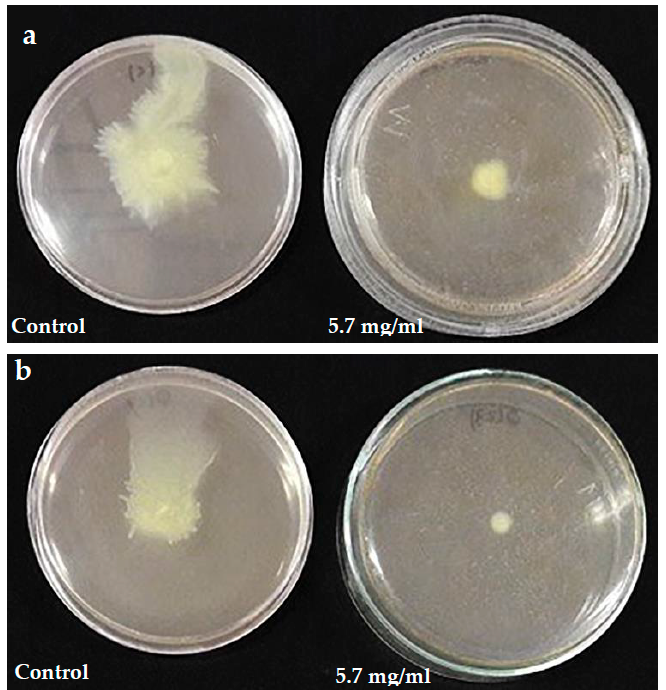
Figure 8. Inhibition of swarming after treatment with 2.9 mg/mL of TEO. ( a ) P. savastanoi pv. glycinea B076; and ( b ) P. syringae Q.